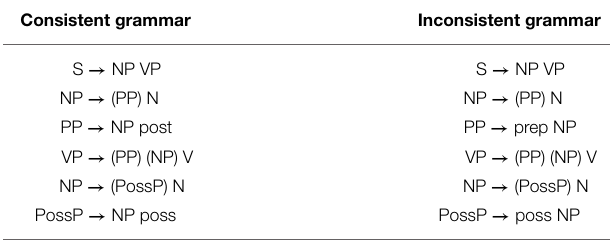
TABLE 3 | The grammars used Christiansen (2000) and Reeder (2004). Consistent grammar Inconsistent